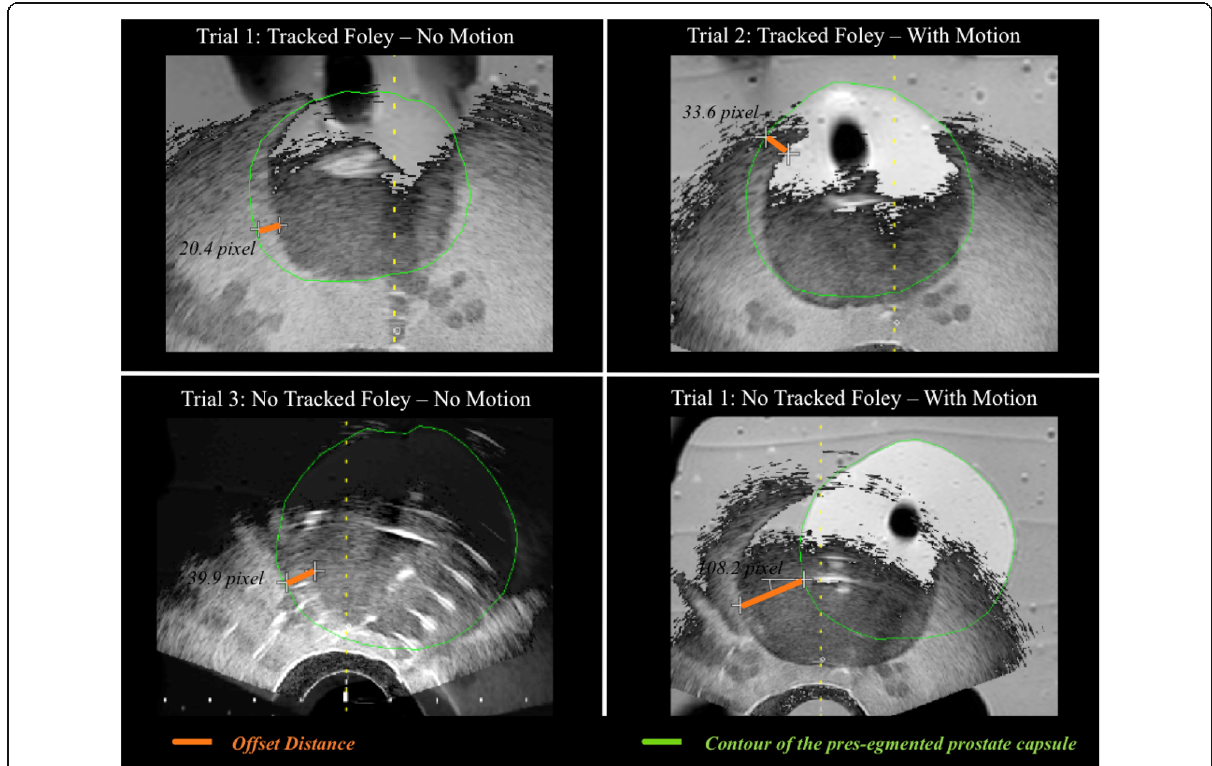
Fig. 7 Maximum offset distance (OD) between the phantom edge on ultrasound (US) and magnetic resonance imaging (MRI) on the axial plane. OD was defined as the distance between the phantom edge on US and perpendicular line striking the same location as seen on the contoured edge on MRI. The green contour is the pre-segmented prostate capsule from the pre-procedural